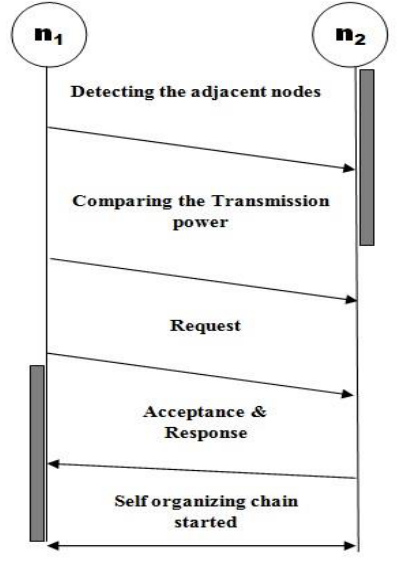
Figure 2. Pairing of Two Nodes.